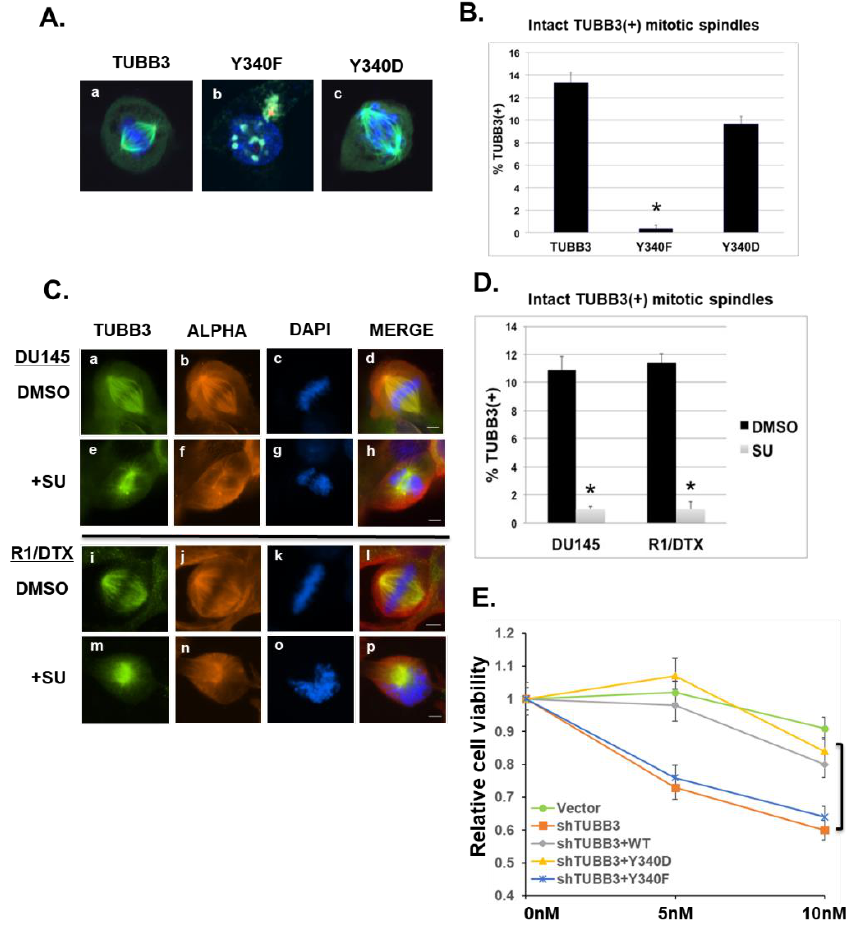
Figure 5. Effects of TUBB3 Y340 phosphorylation on its subcellular localization and mitotic spindle stability and drug sensitivity. ( A ) COS-1 cells were transiently transfected 24 h post-plating with indicated plasmids (TUBB3, Y340F, Y340D). Cells were allowed to grow for an additional 48 h on glass coverslips before collection, fixation, and co-stain with mouse monoclonal anti-TUBB3 (green), rabbit anti-pericentrin (red), and DAPI (blue, for DNA). Images were taken using a Zeiss LSM510 Laser Scan Confocal Microscope. ( B ) Quantification of cell count from 3 independent repeats of experiments shown in Panel (A). All cell counts were conducted by visual inspection. At least 100 total cells were counted for each condition. * p < 0.01. ( C ) DU145 cells (a–h) OR docetaxel-resistant R1/DTX cells (i–p) were grown on glass coverslips for 48 h, then treated for 2 h with either DMSO (a–d, i–l) or